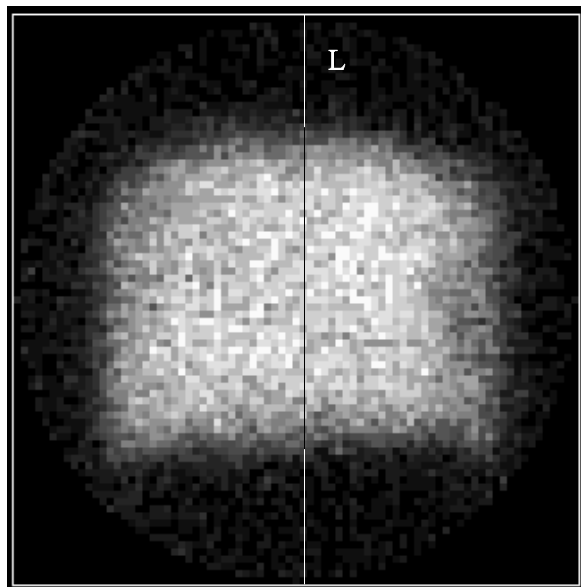
Figura 9. Tomografia em escala milimétrica de uma amostra não perturbada de Podzólico Vermelho- Escuro eutrófico, da Estação Experimental do IAC, em Mococa (SP).